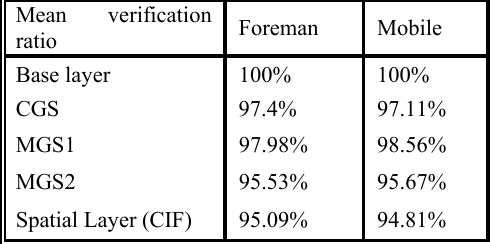
Table 2. Mean verification ratio of Key frame sequences